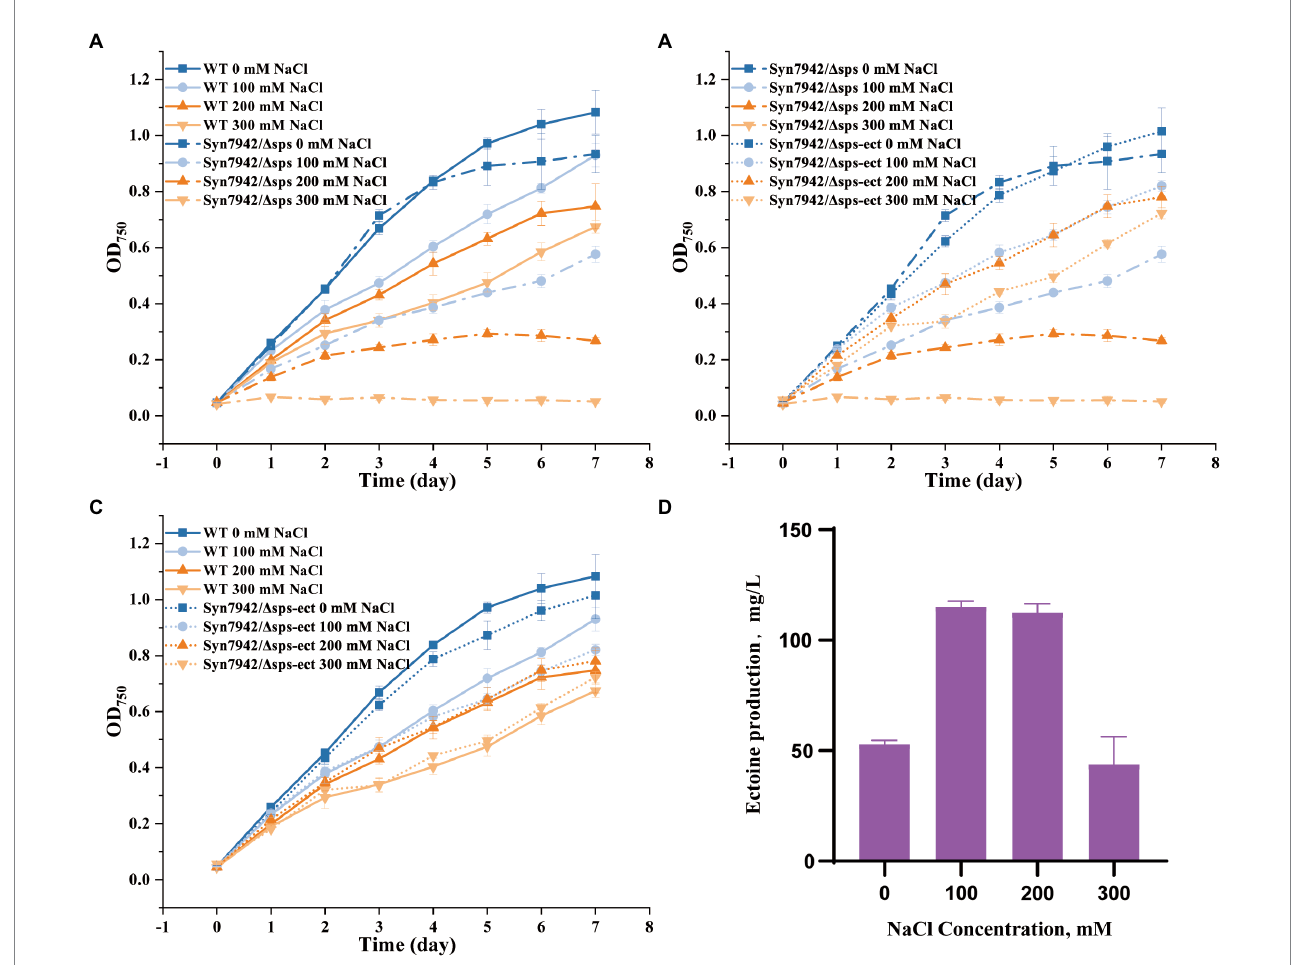
FIGURE 3 Growth curves and ectoine production of WT, Syn7942/ Δ sps, and Syn7942/ Δ sps-ect. (A) Growth curves of WT and Syn7942/ Δ sps under 0, 100, 200, 300 mM NaCl; (B) Growth curves of Syn7942/ Δ sps and Syn7942/ Δ sps-ect under 0, 100, 200, 300 mM NaCl; (C) Growth curves of WT and Syn7942/ Δ sps- ect under 0, 100, 200, 300 mM NaCl; (D) Ectoine production of Syn7942/ Δ sps-ect under 0, 100, 200, 300 mM